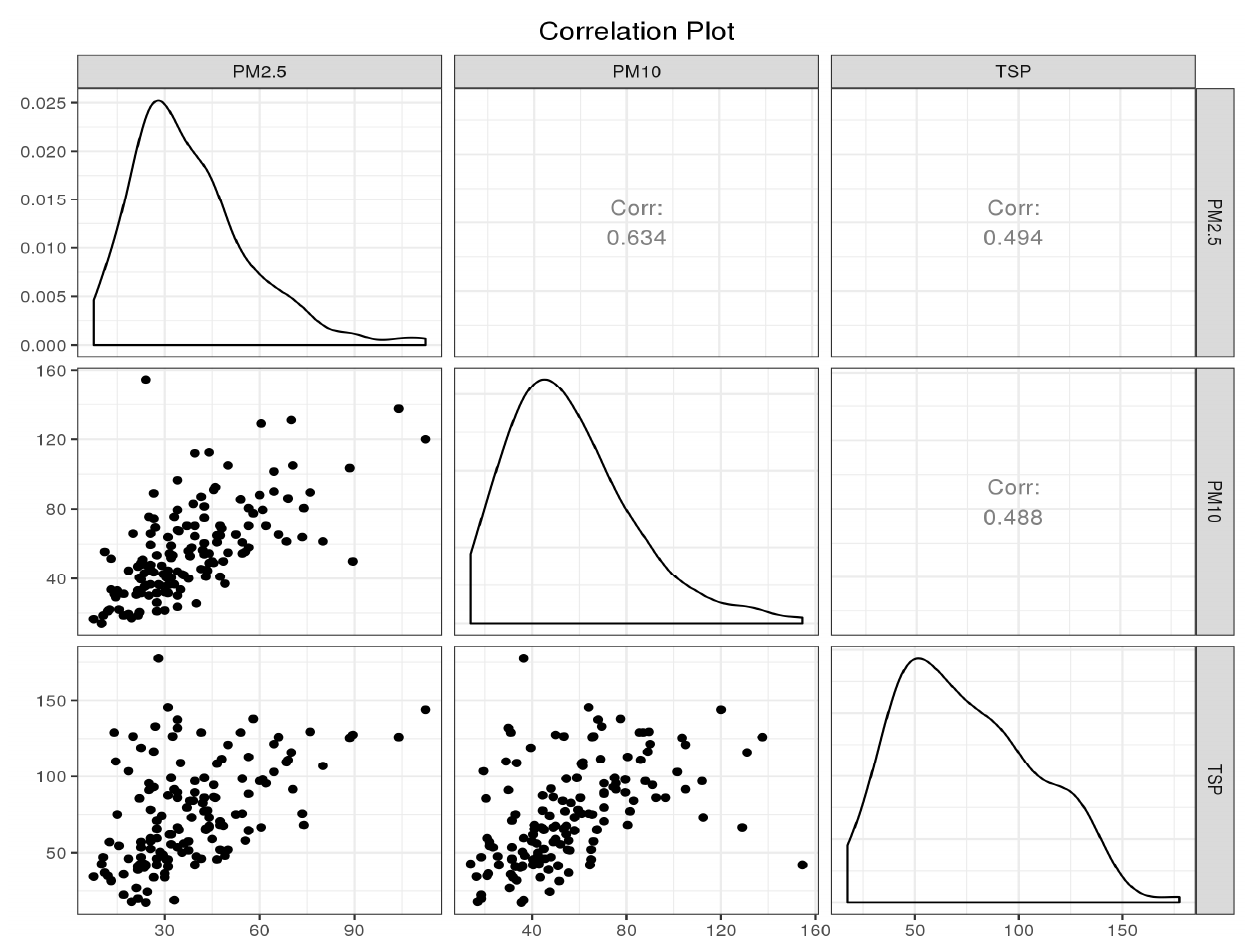
Figure 4. Correlation plot for PM 2.5 , PM 10 , and TSP. Table 4. Significant variable estimates for PM 2.5